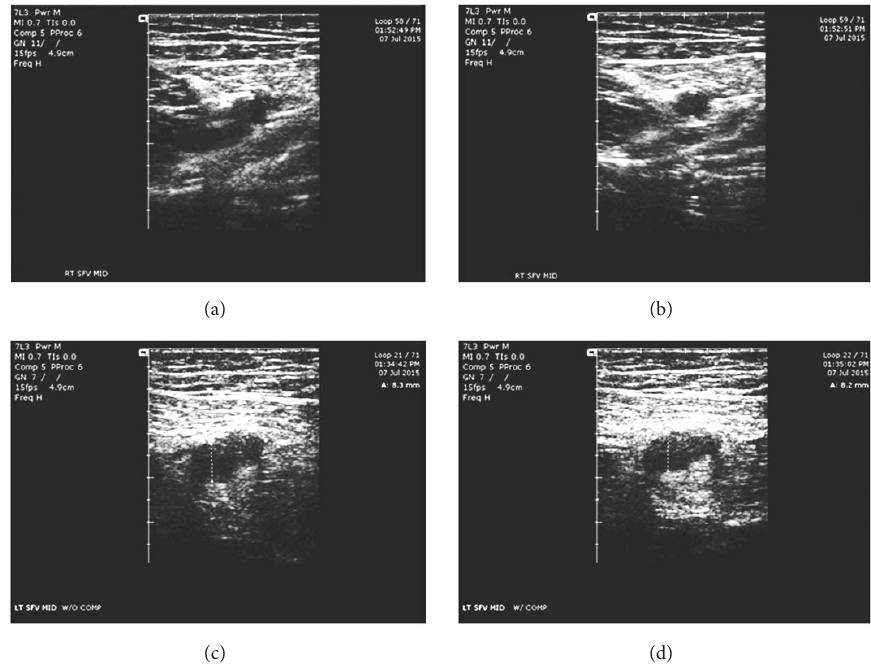
Figure 1: Lower extremity ultrasound findings upon initial evaluation. (a) Uncompressed right superficial femoral vein patent. (b) Compressed right superficial femoral vein completely collapsed. (c) Uncompressed left superficial femoral vein at 8.3 mm. (d) Compressed left superficial femoral vein at 8.2